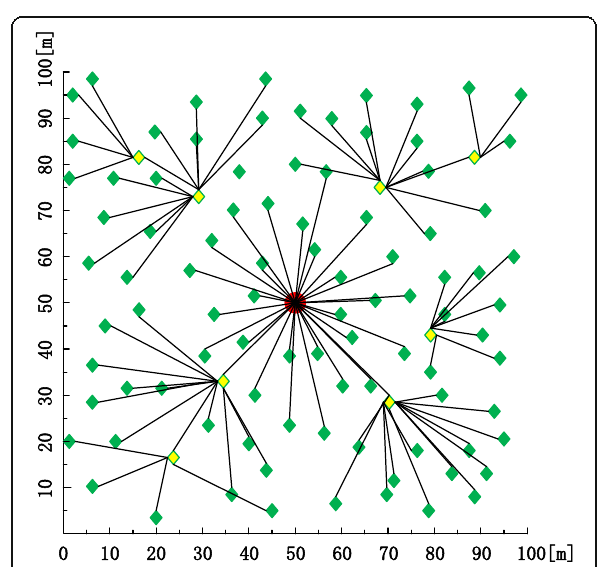
not equal, and there is a clear parent-child relationship, and it is a pyramidal tree structure. In this structure, the top nodes of the network are the coordinator, the other parent nodes are routers, and the terminal nodes are end- devices. The advantages of cluster tree topology are as follows.